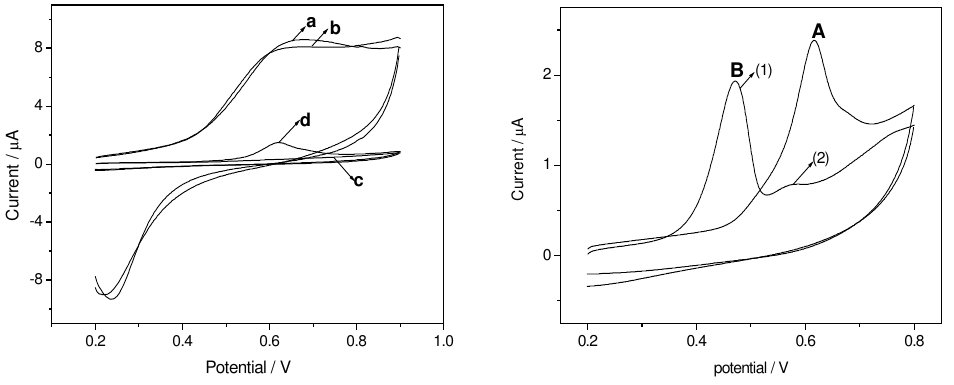
Figure 1. (left) Cyclic voltammograms (CVs) of bare Au electrode (a, b) and DEC SAM/Au (c, d) in a blank solution (a, c) and in a 10 (cid:1) M prochlorperazine solution (b, d). Scan rate: 100 mV/s, accumulation time: 60 s, supporting electrolyte: 0.080 M sodium carbonate buffer (pH 10). Figure 2. (right) CVs of 10 (cid:1) M prochlorperazine (A) and ethopropazine (B) on DEC SAM/Au. Other conditions as in Figure